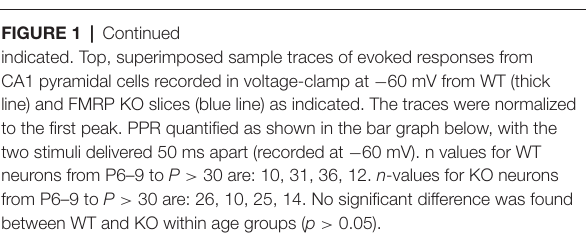
FIGURE 1 | Continued indicated. Top, superimposed sample traces of evoked responses from CA1 pyramidal cells recorded in voltage-clamp at − 60 mV from WT (thick line) and FMRP KO slices (blue line) as indicated. The traces were normalized to the first peak. PPR quantified as shown in the bar graph below, with the two stimuli delivered 50 ms apart (recorded at − 60 mV). n values for WT neurons from P6–9 to P > 30 are: 10, 31, 36, 12. n -values for KO neurons from P6–9 to P > 30 are: 26, 10, 25, 14. No significant difference was found between WT and KO within age groups ( p >